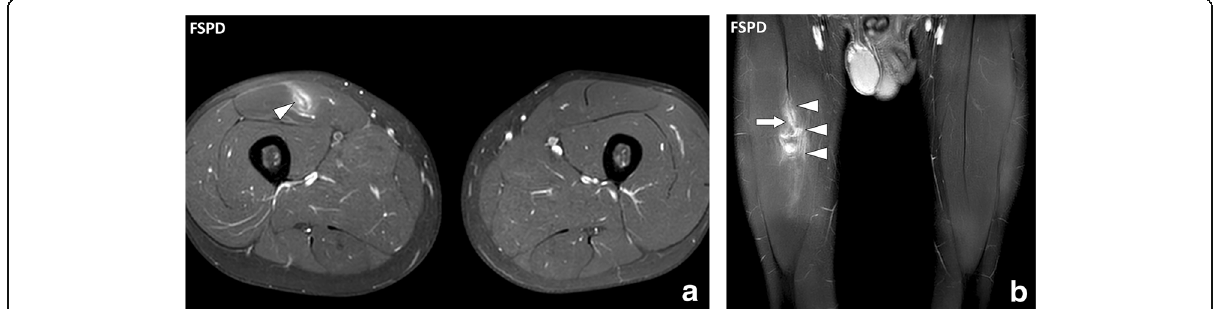
Fig. 5 a Axial and ( b ) coronal FSPD images of the thighs of 19-year-old male with tear of the myotendinous junction of the right rectus femoris muscle after a soccer game. The aponeurosis of the right rectus femoris muscle is focally interrupted (arrow) with extensive fluid infiltration around the myotendinous junction and the tear (arrowheads)